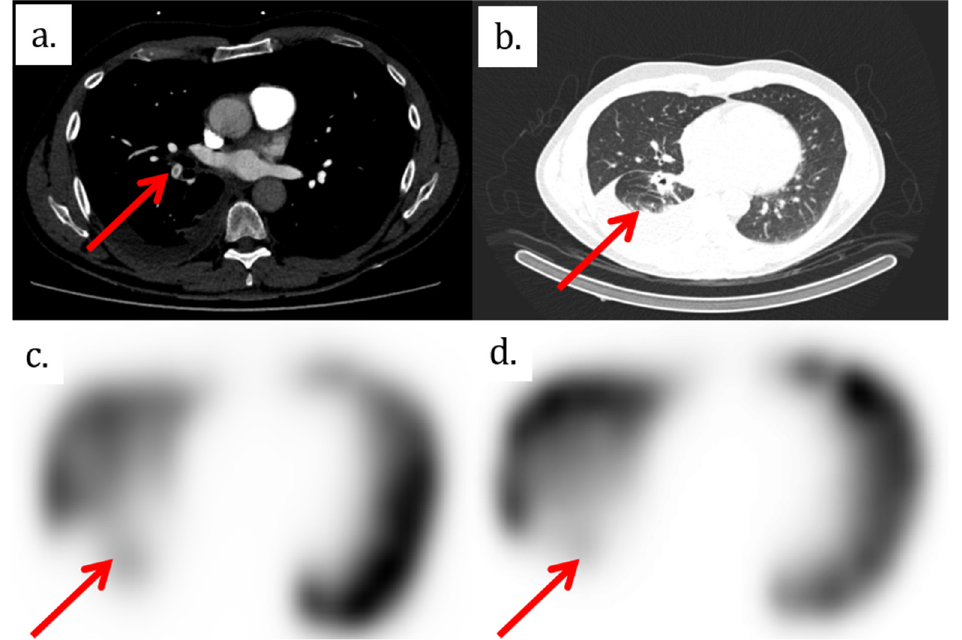
Figure 1. ( a ) Axial view of CTPA shows a segmental filling defect in a segmental artery of the right lower lobe. ( b ) Lung CT images show retractile neoplastic lesion of the right inferior lobe with a low right pleural effusion. ( c ) and ( d ) show perfusion and ventilation SPECT images, respectively, with a matched defect in the right lower lobe.